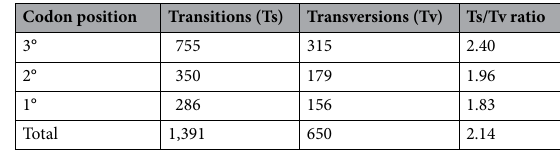
Table 1. Frequency and type of nucleotide substitutions at codon sites.